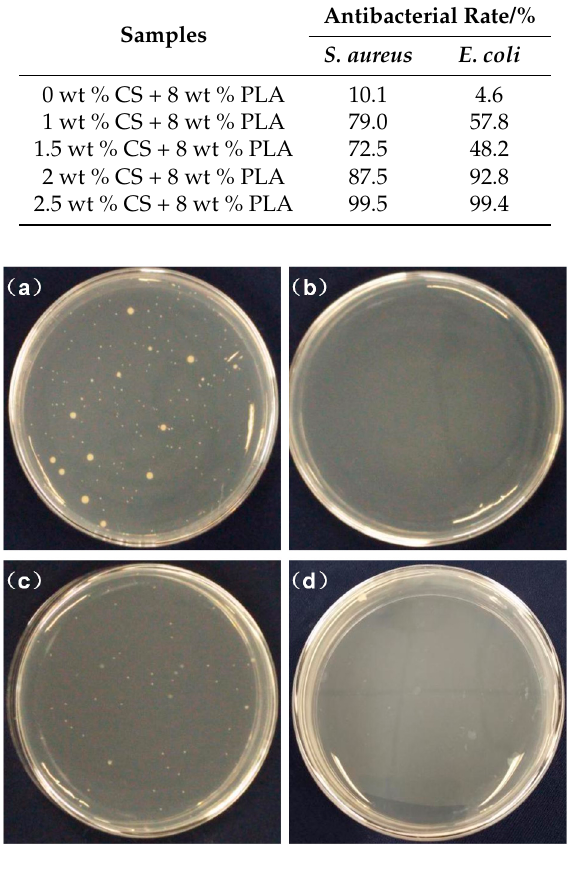
Figure 7. Antibacterial activity of the fibrous membranes against S. aureus ( a , b ), and E. coli ( c , d ). The samples are cotton ( a , c ), and fibrous membranes with 8 wt % PLA and 2.5 wt % CS ( b , d ).